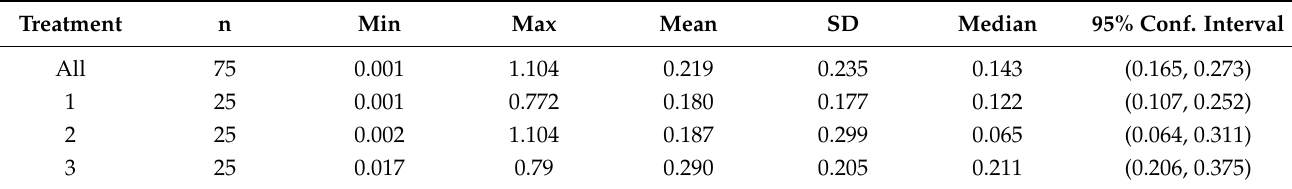
Table 4. Descriptive statistics for enamel volume loss.